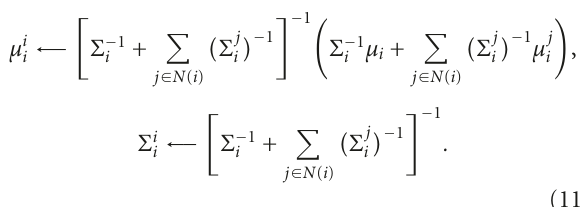
Figure 2: An intermediate stage of message passing. The P the camera parameters that are passed between